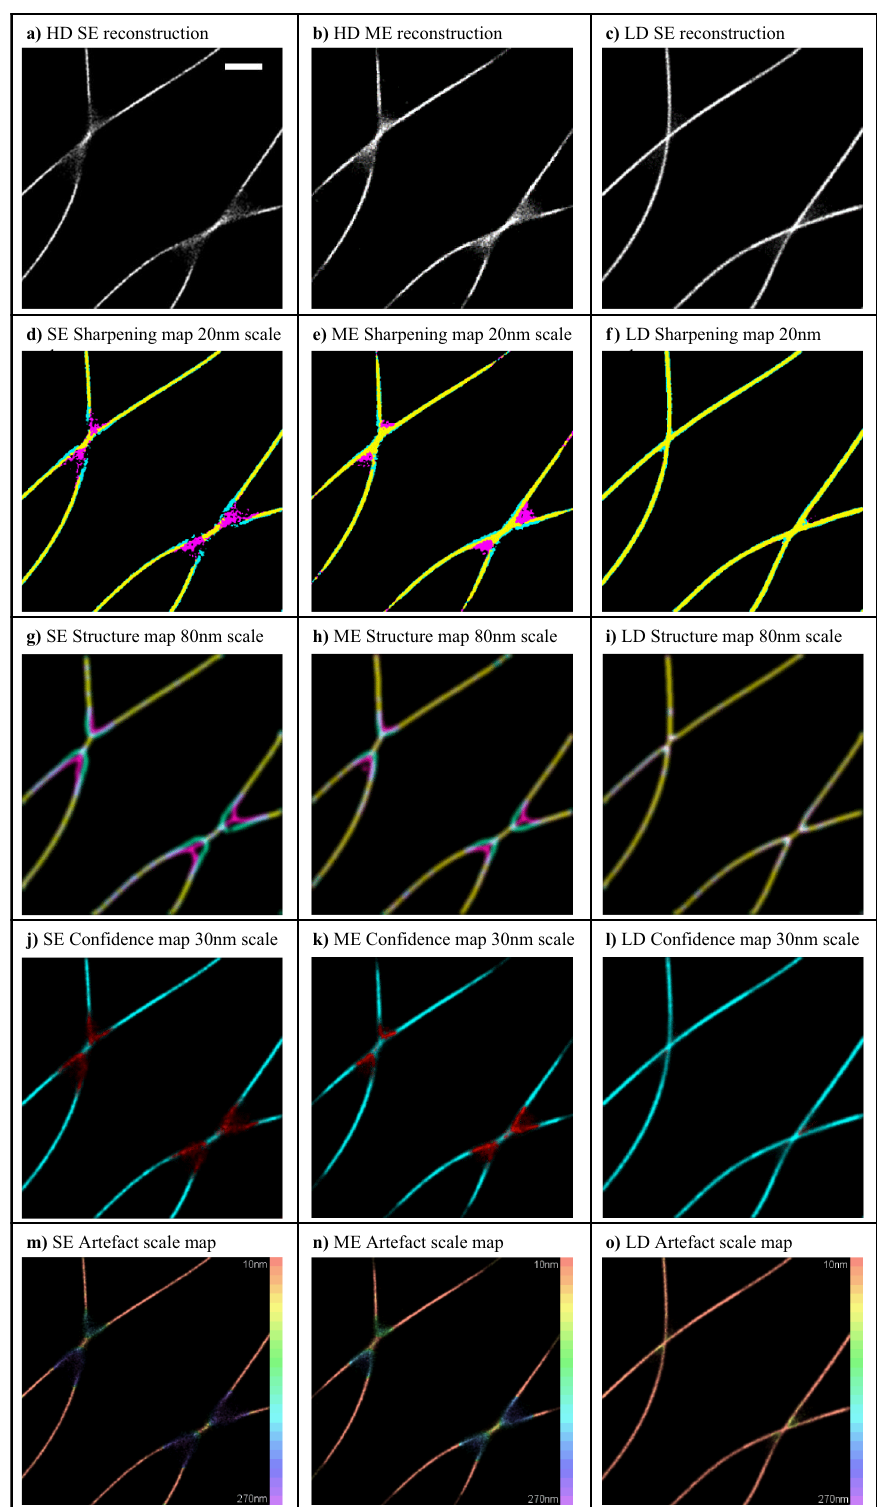
Testing with benchmark data . In order to test the performance of HAWKMAN we selected simulated datasets from the Locali- sation Microscopy Challenge 14,15 where both low and high emitter density datasets were available. This allowed us to benchmark the performance of HAWKMAN when using a HAWK reference image, against when using a low density (ground truth) reference image, which ensured that the location